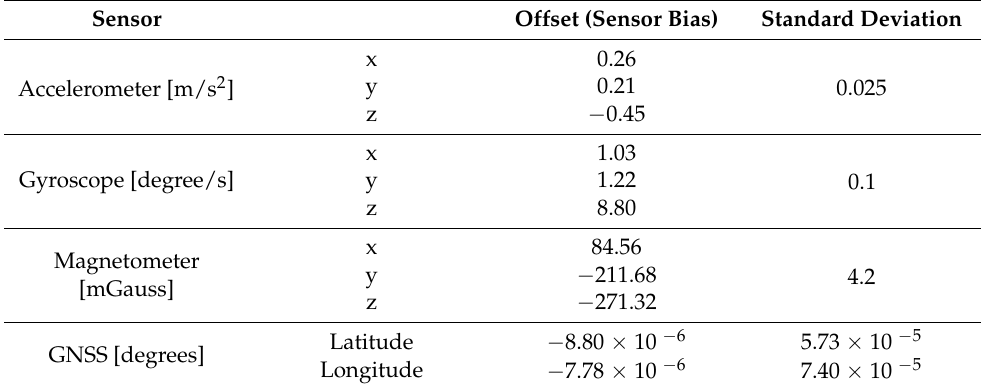
Table 7. Statistical results of positioning sensor accuracy (internal measurement unit (IMU) and Global Navigation Satellite System (GNSS)) during the experiment.